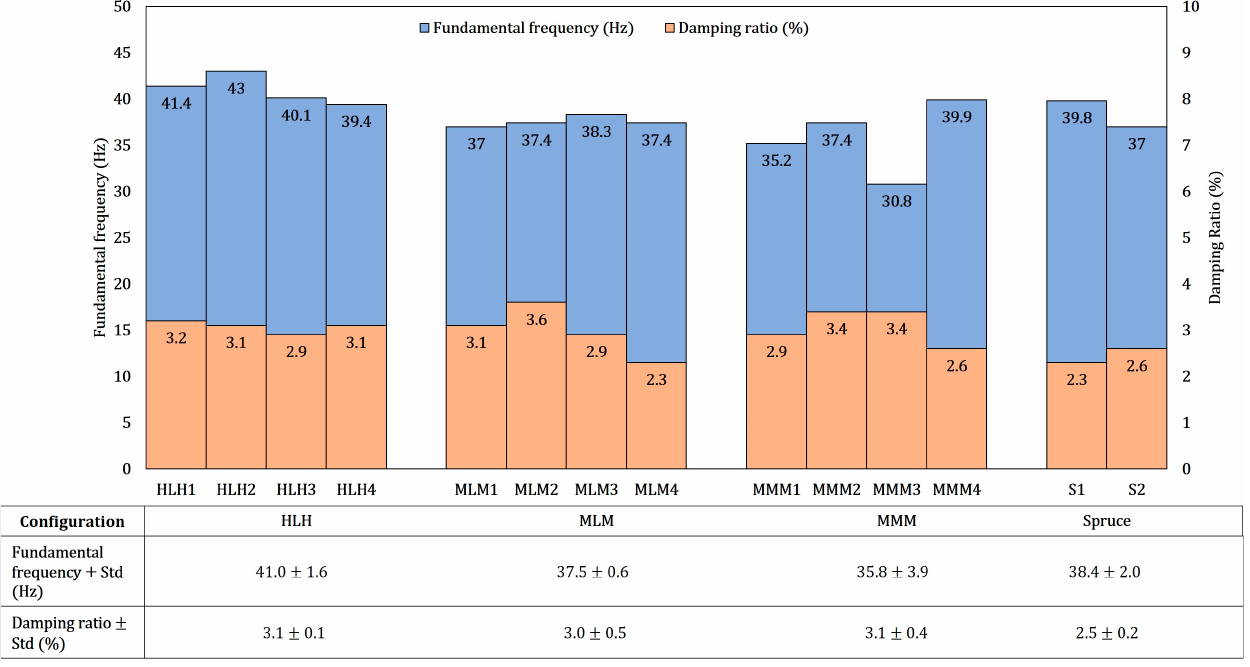
Figure 8. Experimental results of the fundamental frequency and damping ratio. The average values of λ 1 calculated by extrapolating Equation (12) are summarized in Table 6. Table 6. Average values of λ 1 .